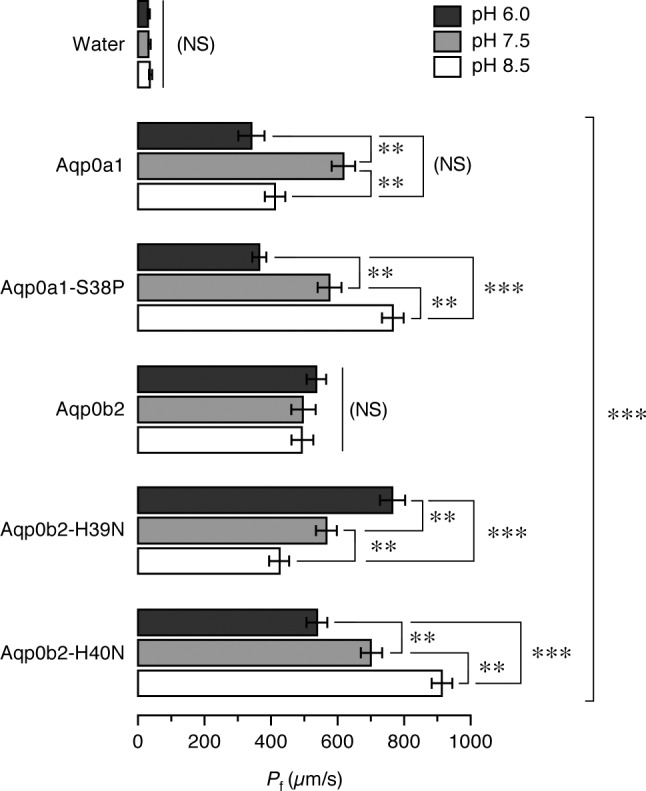
Role of Ser38 and His39-His40 on Atlantic salmon Aqp0a1 and -0b2 pH sensitivity. Osmotic water permeability (Pf) of X. laevis oocytes injected with water or cRNA encoding wild-type Aqp0a1 or Aqp0b2 or different mutants in which Ser39 was replaced by Pro in Aqp0a1 (Aqp0a1-S39P) or in which a single His in position 39 or 40 replaced the double His in Aqp0b2 (Aqp0b2–H40N and Aqp0b2-H39N, respectively). The Pf was calculated using an estimated surface area of 9× the geometric area. Oocytes were exposed to different pH before and during the swelling assays. Data are the mean ± sem (n = 12 oocytes per construct) of a representative experiment. Significant differences (*P < 0.05; **P < 0.01; ***P < 0.001) for each construct at the 3 pHs are indicated. The bracket indicates significant differences with respect water-injected oocytes. NS, not significant.